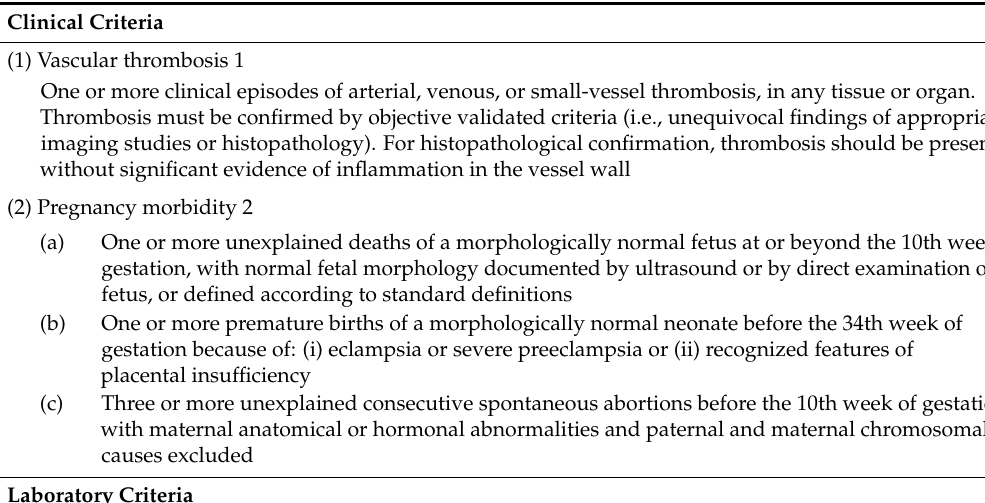
Table 1. Diagnostic criteria of antiphospholipid syndrome [4]. The APS is present if at least 1 of the clinical criteria and 1 of the laboratory criteria that follow are